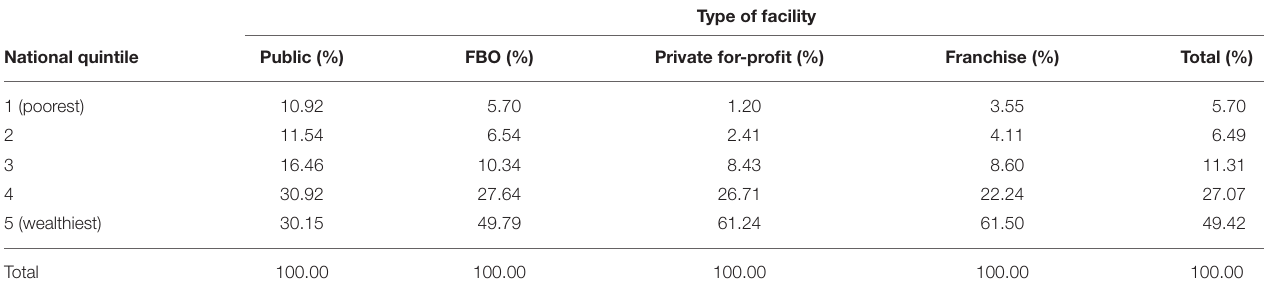
TABLE 5 | Proportion of clients in each national wealth quintile, by Sector.